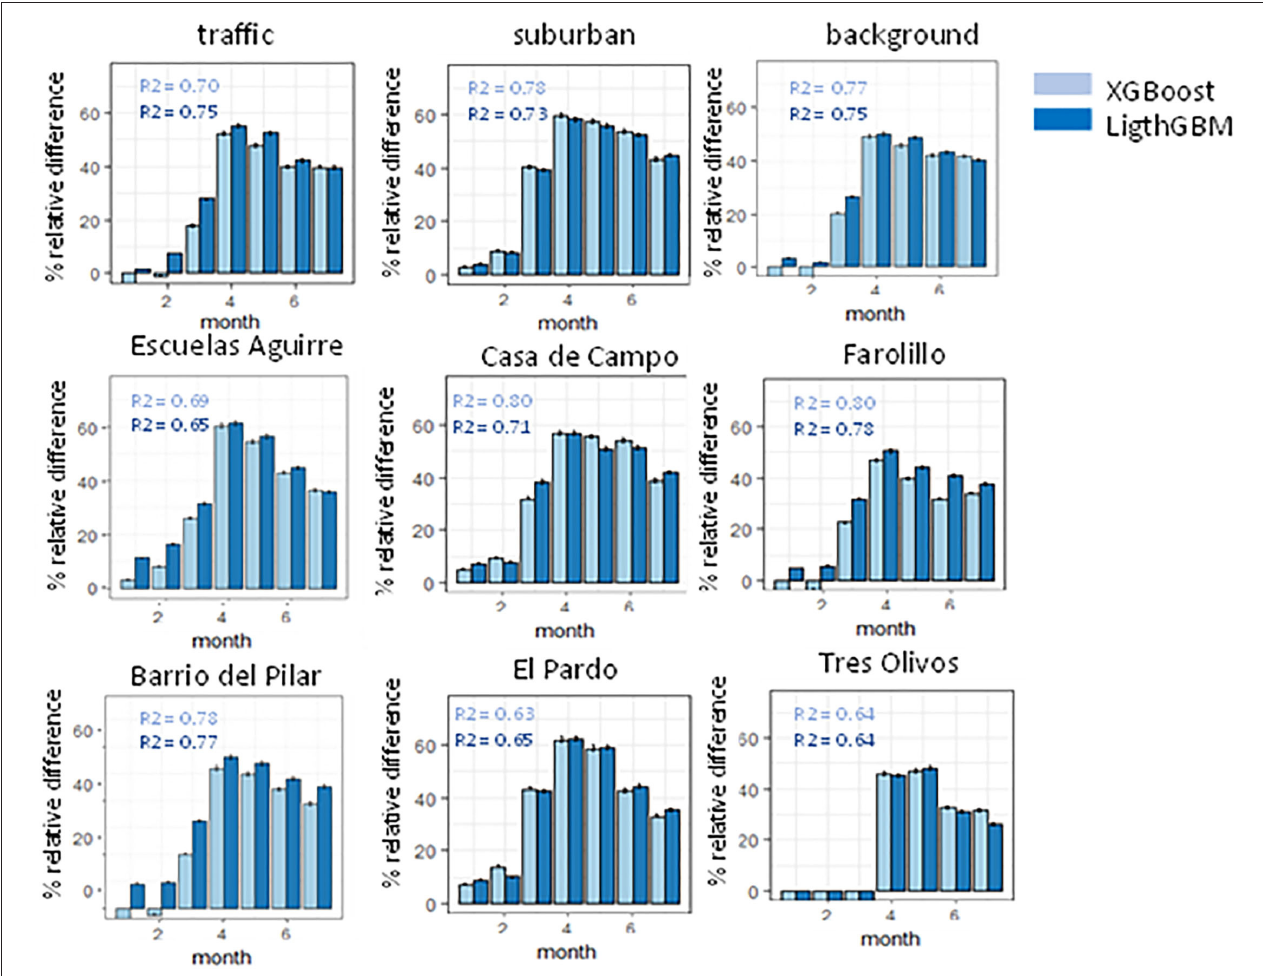
FIGURE 8 | The percentage relative difference between the NO 2 concentration estimated by the models and the measurements from the stations, aggregated by month and type of station. The results of applying the pool model for the two selected air quality stations (AQSs) of each type are also